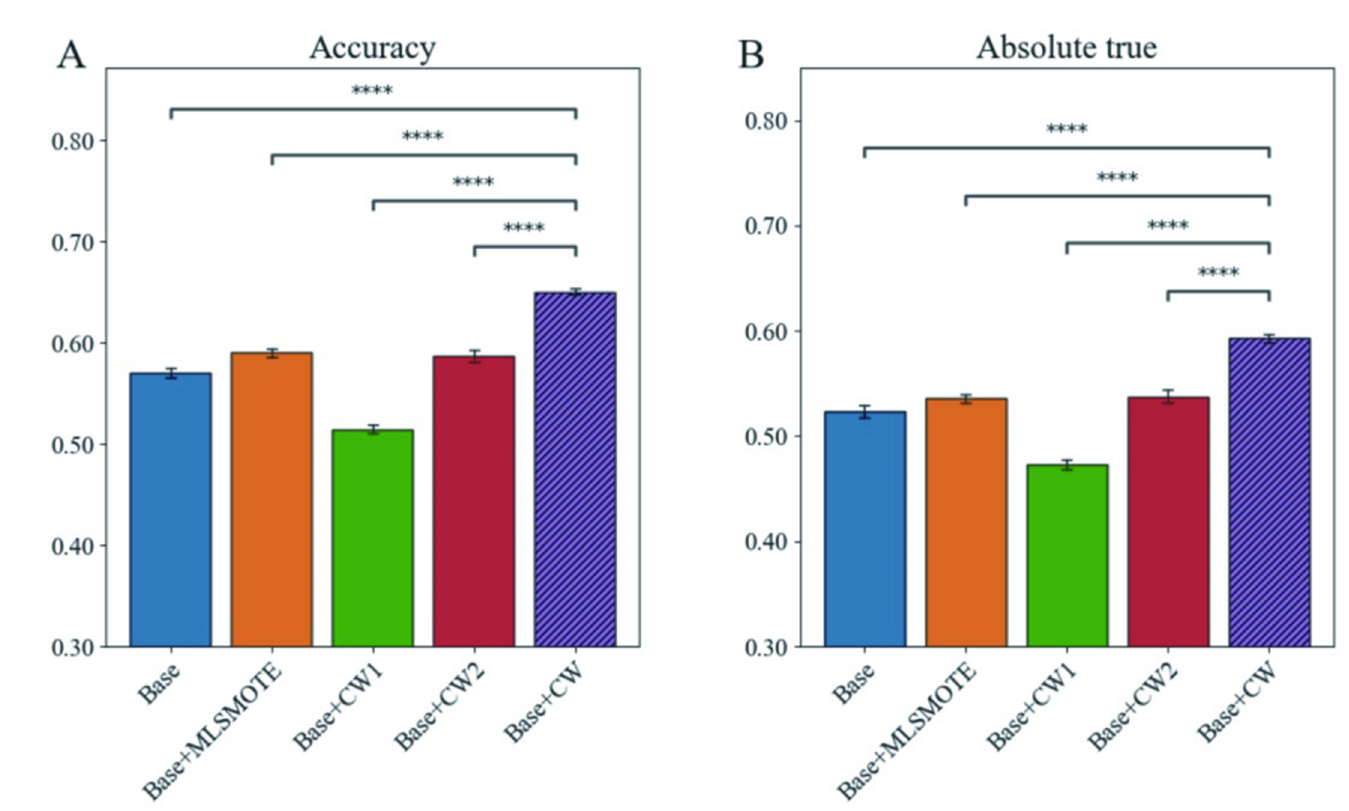
Fig 3. The performance comparison of the base (CNN+BiLSTM+MHSA) model with different algorithms for solving the problem of imbalanced data classification on the test set. A. Accuracy; B. Absolute true. Base+CW (our model) is significantly better at P-value < 0.001 (t-test).